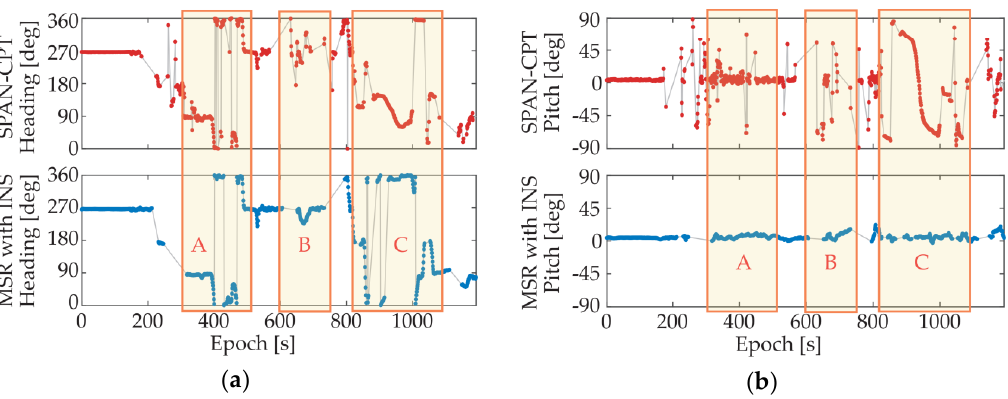
Figure 15. Attitude results of SPAN-CPT and MSR with INS integrated system. ( a ) Heading; ( b ) Pitch.